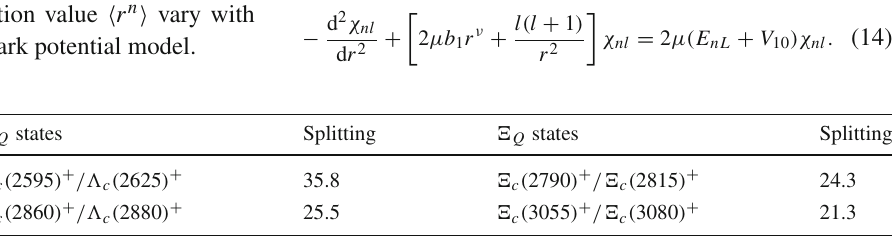
Table 4 The measured mass splittings of the 1 P and 1 D states of (cid:9) c and (cid:3) c baryons due to the spin-orbit interaction. The corresponding spin-parity quantum numbers of these states can be found in Table 1